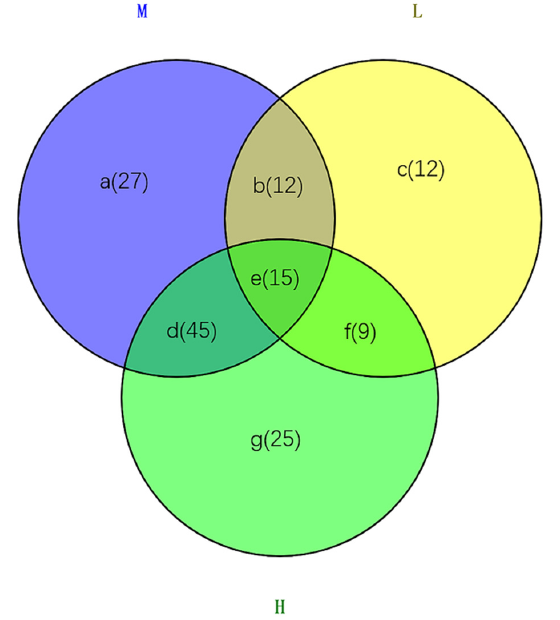
Figure 4. Venn plot for number of differential metabolites impacted by L, M and H extract solutions. The overlaps of two of the three circles indicate the number of metabolites impacted by the two. The overlap of the three circles indicates the number of metabolites all impacted by three solutions. The letters a to g represent different parts of the Venn plot. Numbers in parentheses represent the number of metabolites. Details of the names and changes of metabolites can be seen in Table S1 in Supplementary.